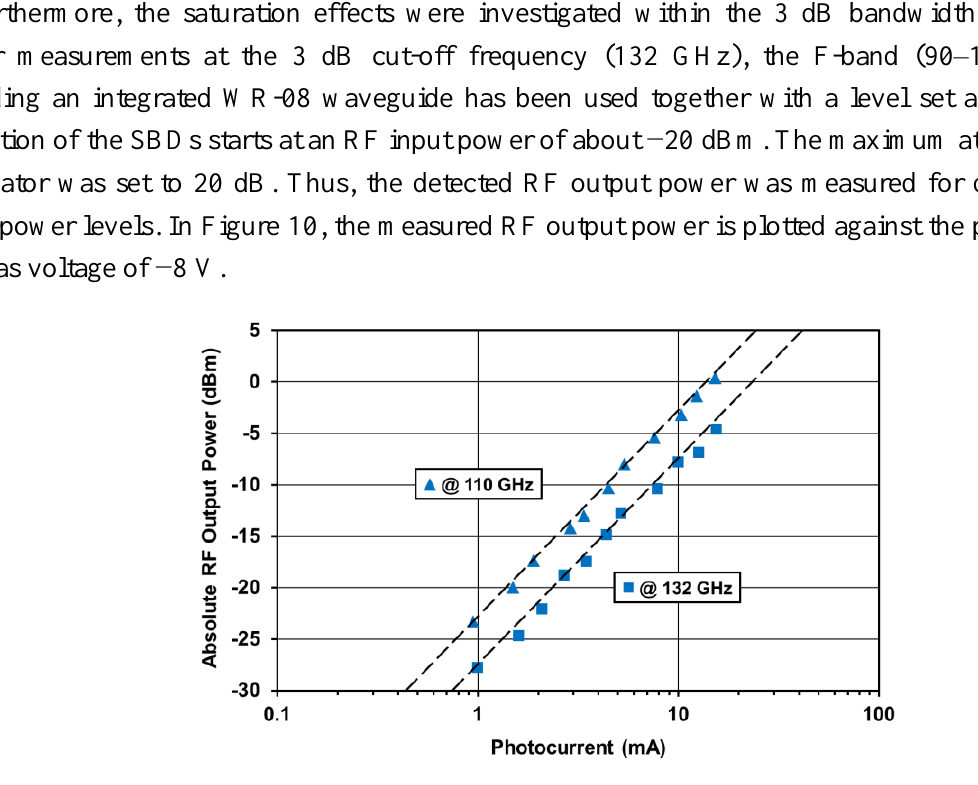
Figure 10. Measured RF output power plotted against the photocurrent for a bias voltage of −8 V at the frequencies of 110 GHz and 132 GHz. The dashed lines show the simulated output power for the RF responsivities of 0.24 A/W (110 GHz) and 0.14 A/W (132 GHz). As shown in Figure 10, even at the 3 dB cut-off frequency no saturation effects occur and